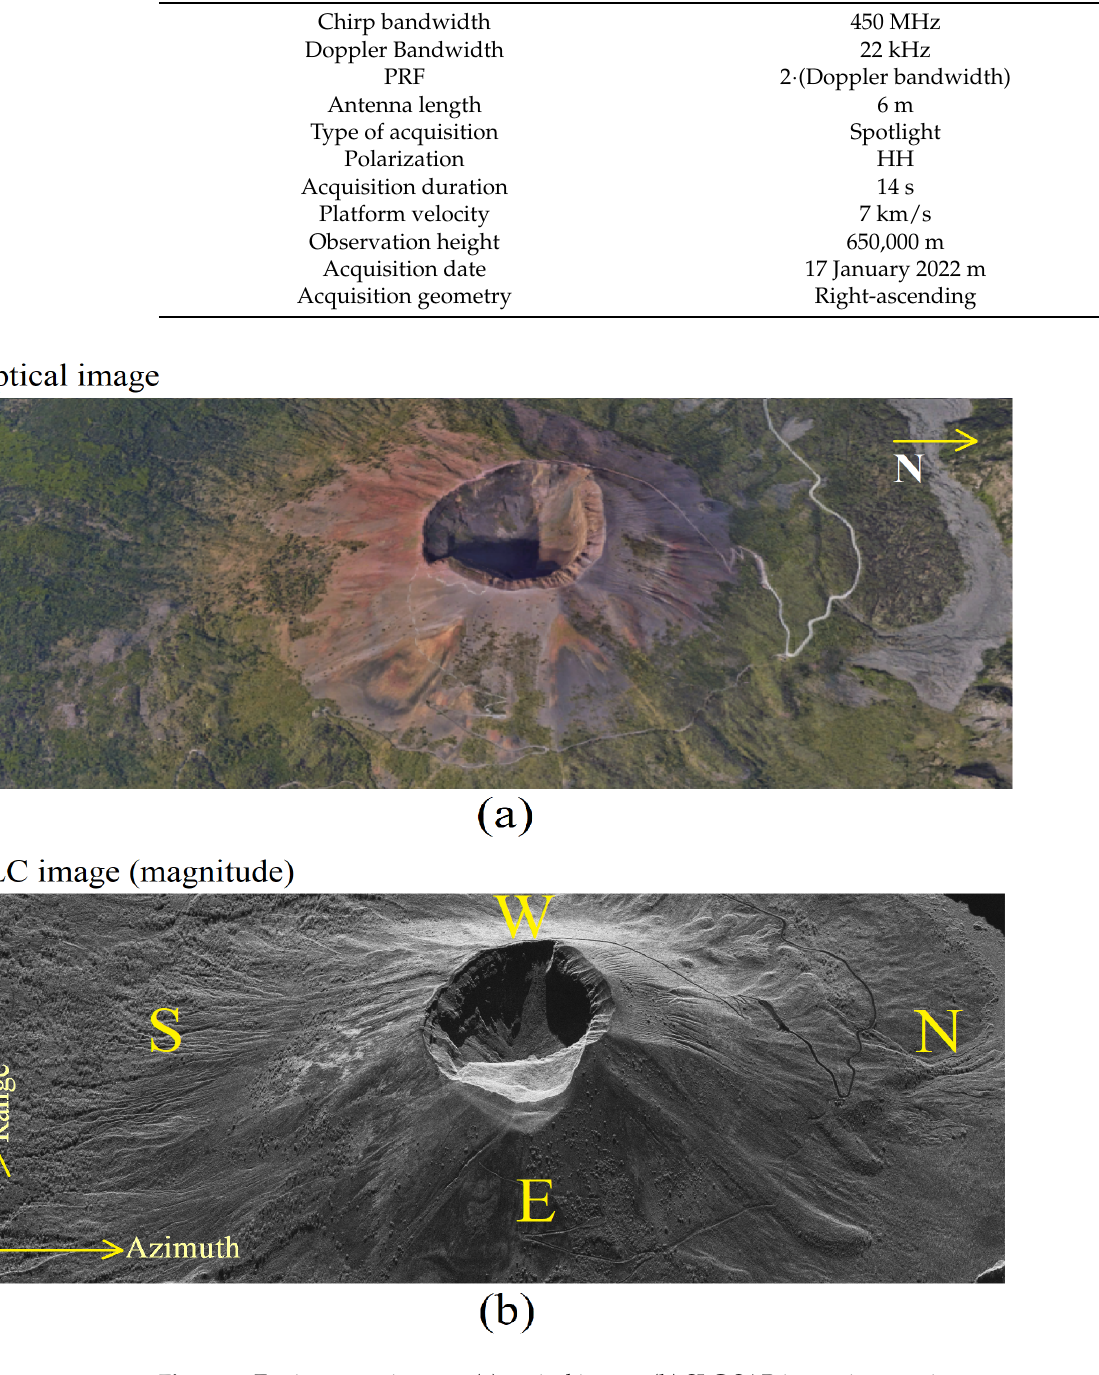
Figure 5. Environment images. ( a ) optical image. ( b ) SLC SAR image in